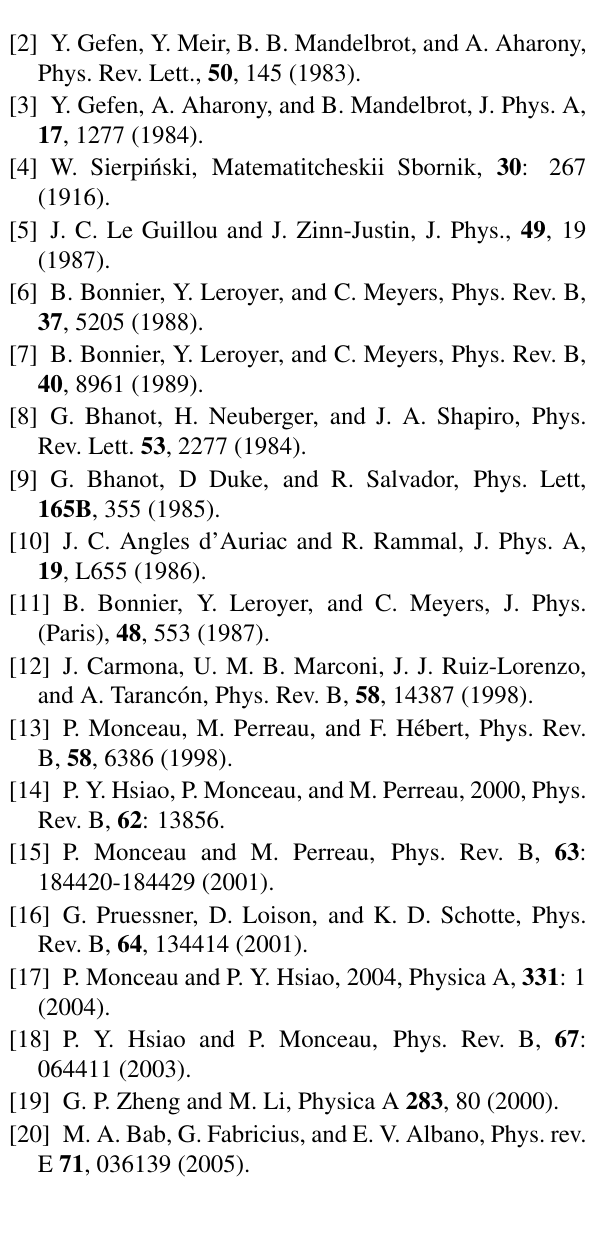
Figure 8. Plots of log[ T c ( 1 )] versus d h , dotted lines are linear fits (left) and b ( n ; p ) versus n for p = n (cid:0) 2, p = n (cid:0) 4, p = n (cid:0) 6, p = n (cid:0) 8 (right)